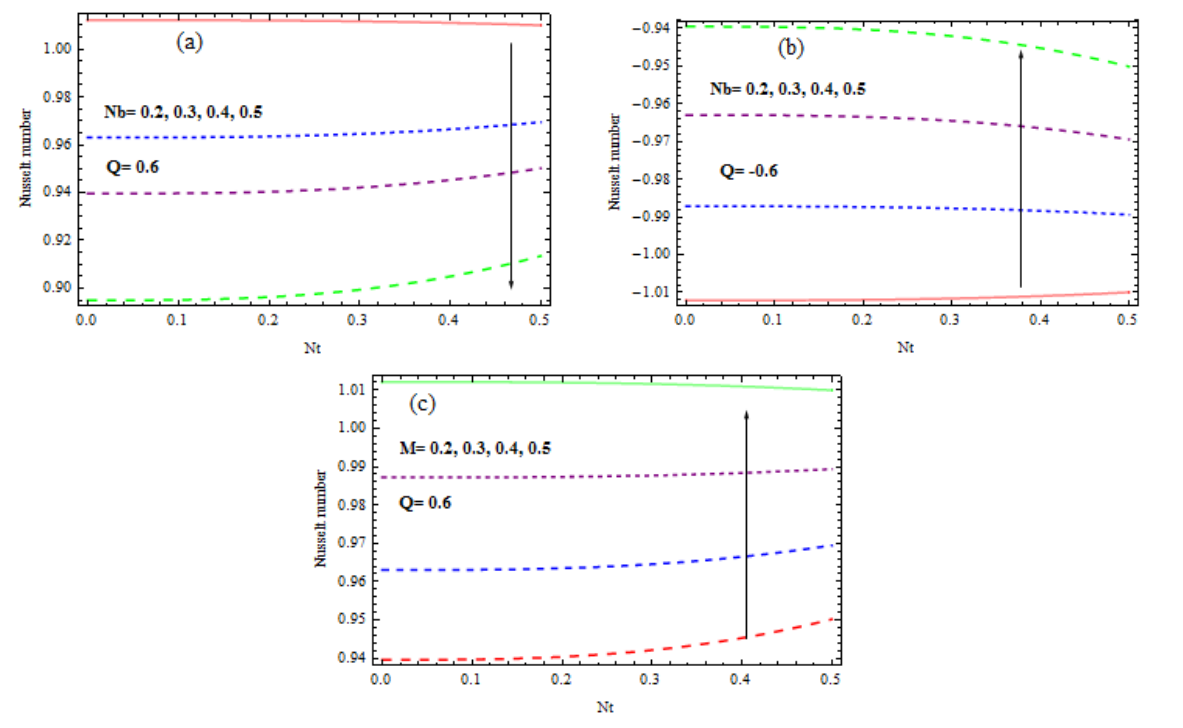
Figure 20. ( a – c ) Variation of Nusselt number for ( a ) Nb when Q = 0.6, ( b ) Nb when Q = − 0.6, ( c ) M.